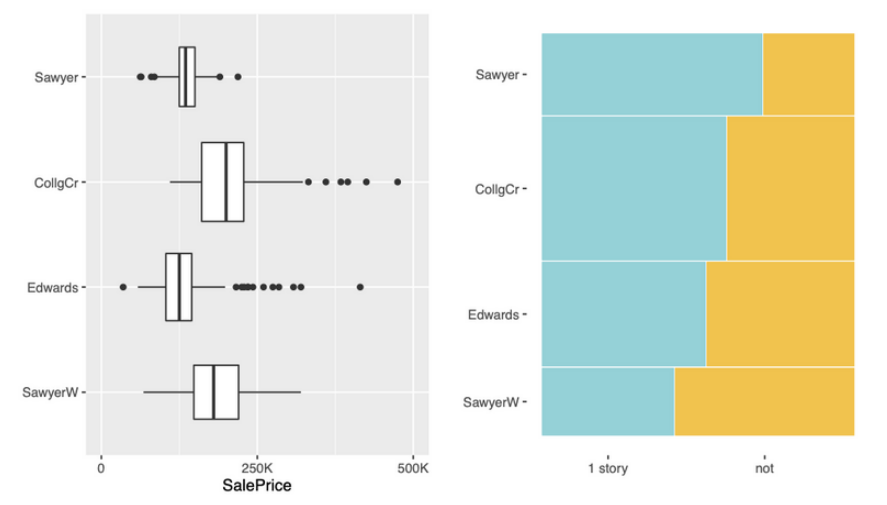
Figure 1. Sale prices and proportions of single story houses in four neighborhoods of Ames,